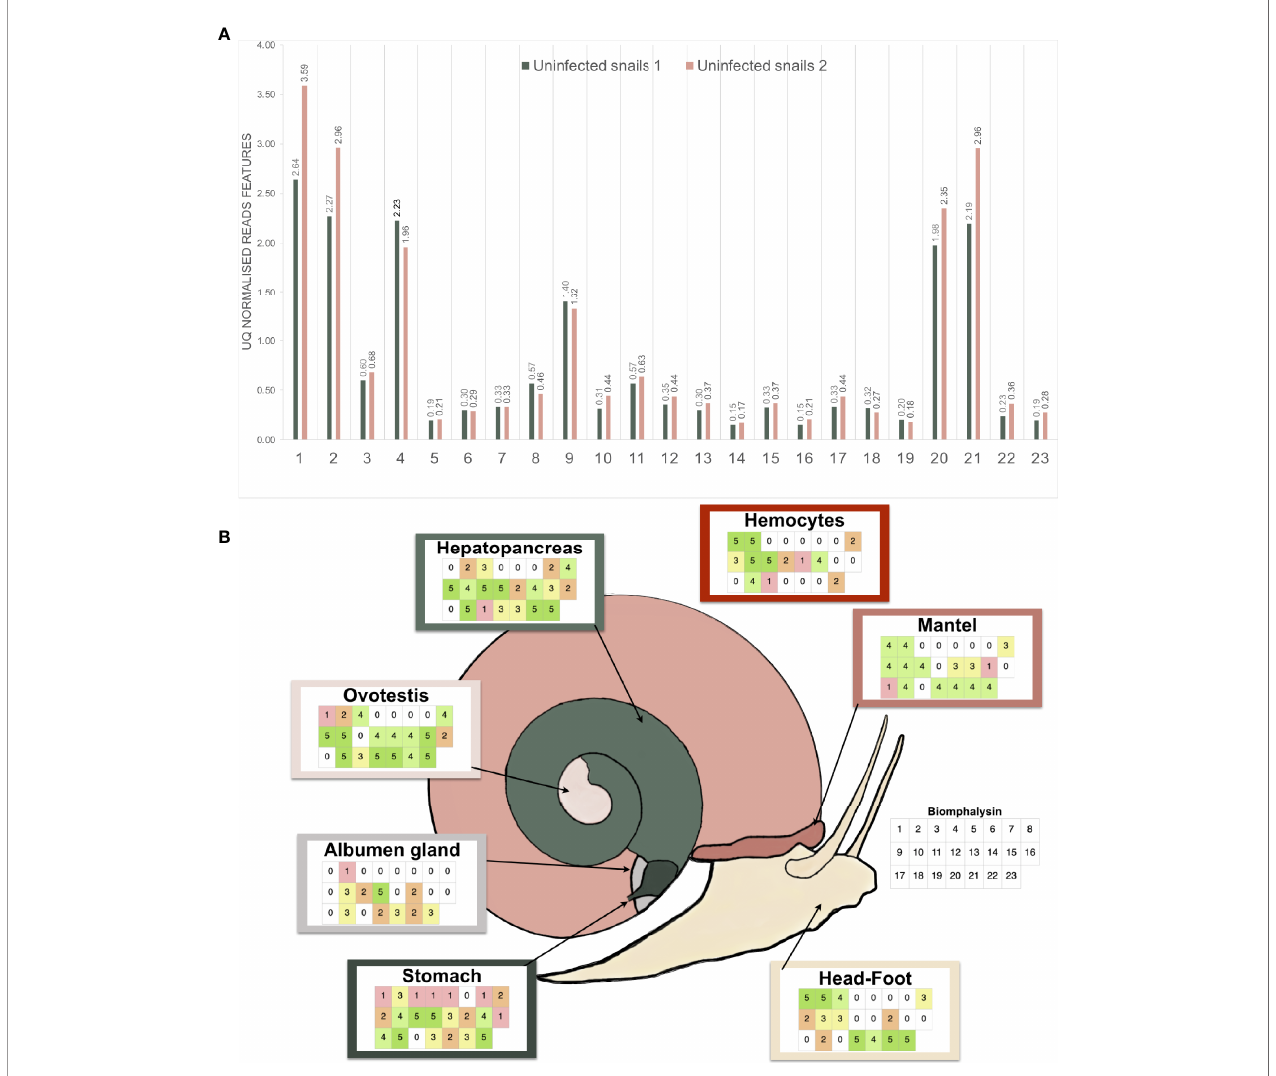
FIGURE 7 | Expression analysis of the biomphalysin family. (A) Constitutive expression of biomphalysins members in whole snails rnaseq dataset (Pinaud et al., 2016). Transcripts abundance for all 23 biomphalysins retrieved from RNAseq experiment performed on two pools of 20 uninfected snails. Libraries from uninfected snails 1 and 2 are highlighted in light-green and pink, respectively. Counts were normalized by upper-quartile (UQ) division for each library. (B) Patterns of expression of biomphalysins in different snail tissues. Each table represents the presence of the 23 biomphalysin transcripts in each tissue by RT-PCR, from biomphalysin 1 in the upper left case to biomphalysin 23 in the lower right case of each table. A code color was used and corresponds to the number of snails for which the tested biomphalysin was detected in a given tissue. As example, an uncolored case indicates that the biomphalysin studied was not expressed in any